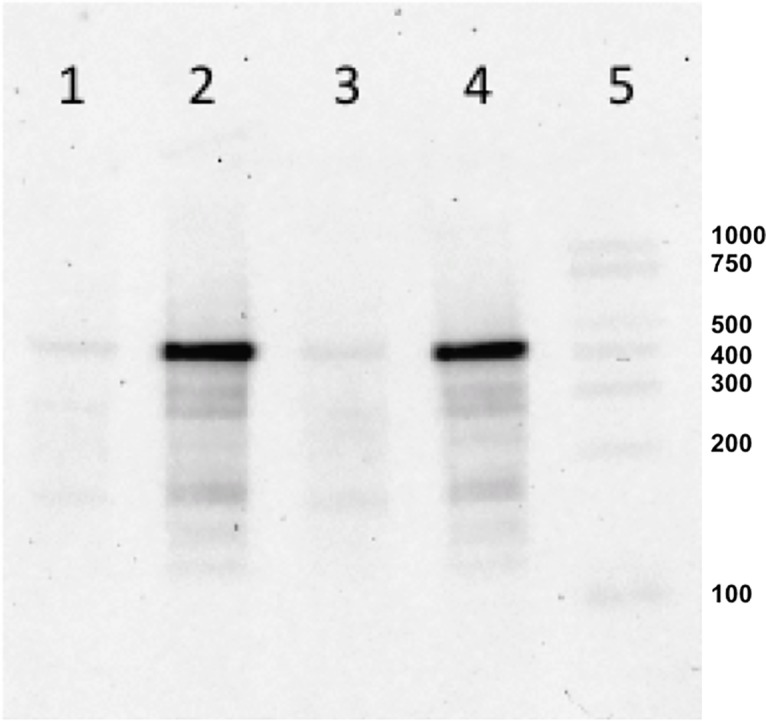
Northern blot analysis.10% TBE-urea polyacylamide gel lanes were loaded with purified W83 RNA isolated from the following culture conditions 1) HL-Stationary phase 2) HL-Log-phase 3) HR-Stationary-phase 4) HR-Log-phase 5) RNA Standard.